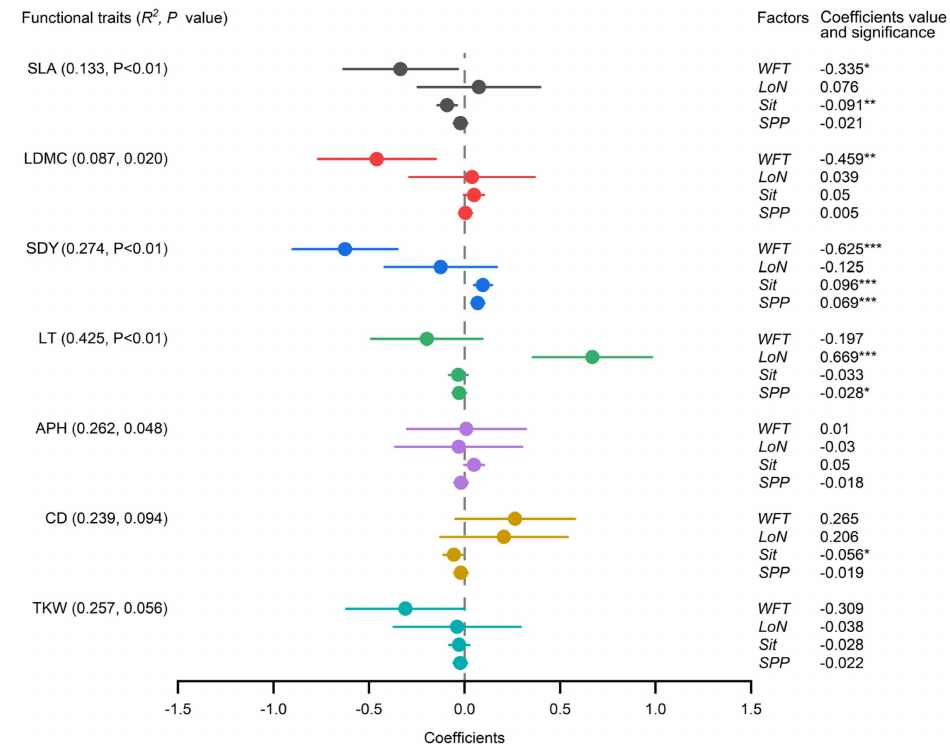
Figure 8. Response of functional traits to WFTs, landslides, sample sites and species. Abbreviations are as follows: WFT, woody plant functional types; LoN, landslide or not; Sit, sample sites; SPP, species; SLA, specific leaf area; LDMC, leaf dry matter content; SDY, stem density; LT, leaf thickness; APH, average plant height; CD, crown diameter; TKW, thousand kernel weight; *, p < 0.05; **, p < 0.01; ***, p < 0.001.